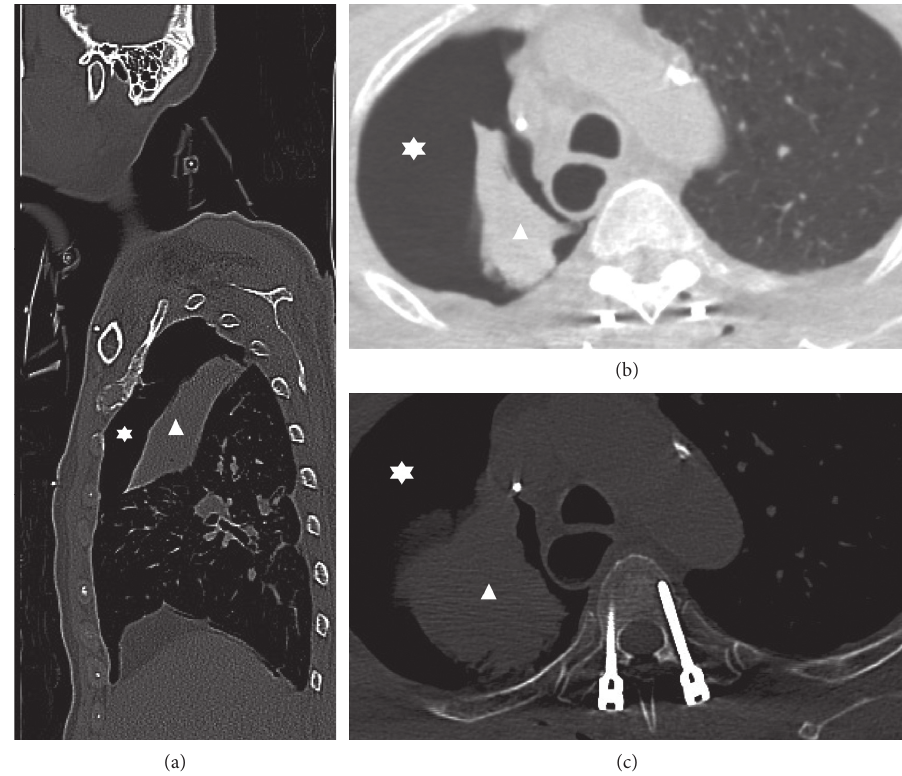
Figure 5: Postop immediate CT showed right apical lung pneumothorax (star) and consolidation at the right lung, leading to the ra- diologist’s suspicion of tumor or collapsed lung (triangle): (a) sagittal view; (b) lung